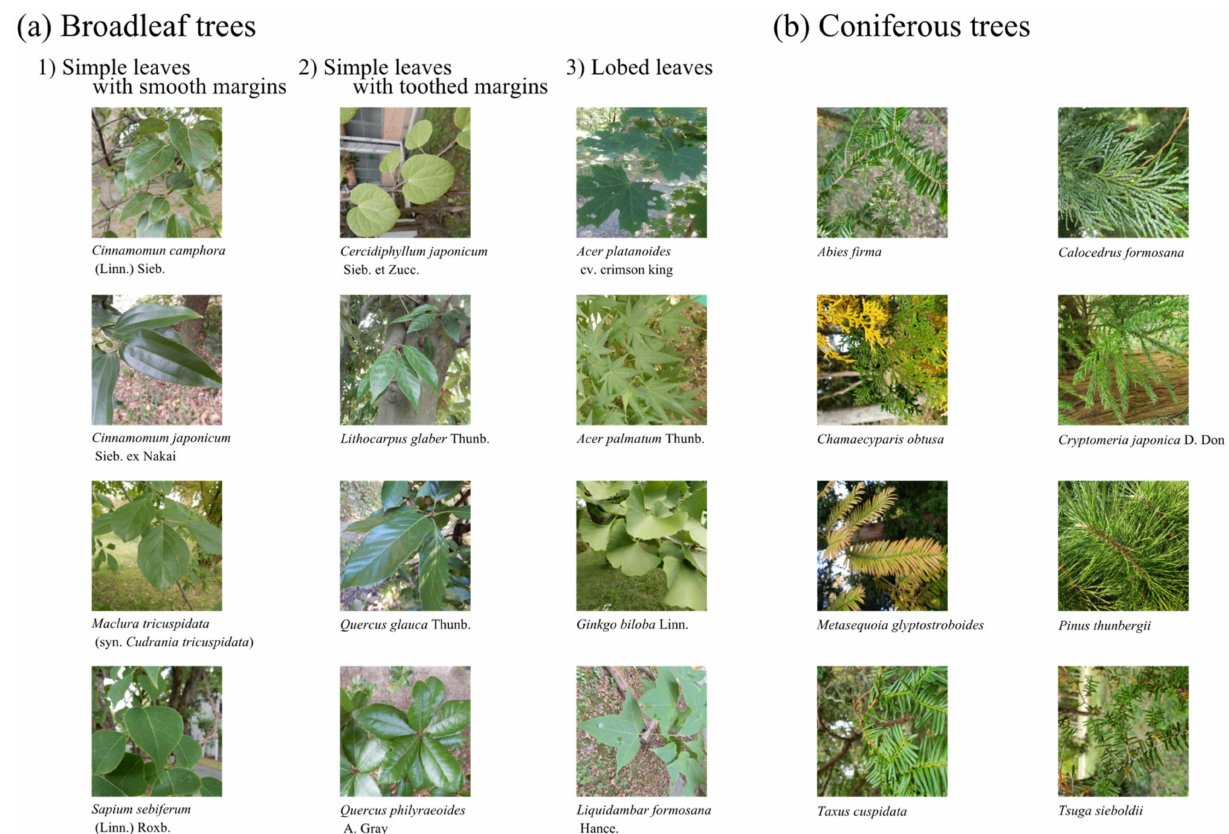
Figure 1. Focal species and classification based on broadleaf and coniferous